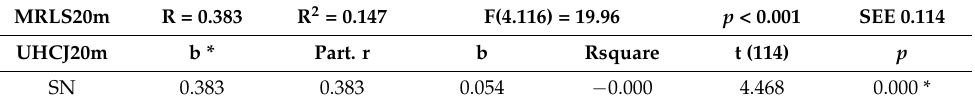
Table 5. Results of stepwise backward regression analysis of the set of kinematic parameters of the UHCJ20m test and the results in the MRLS20m